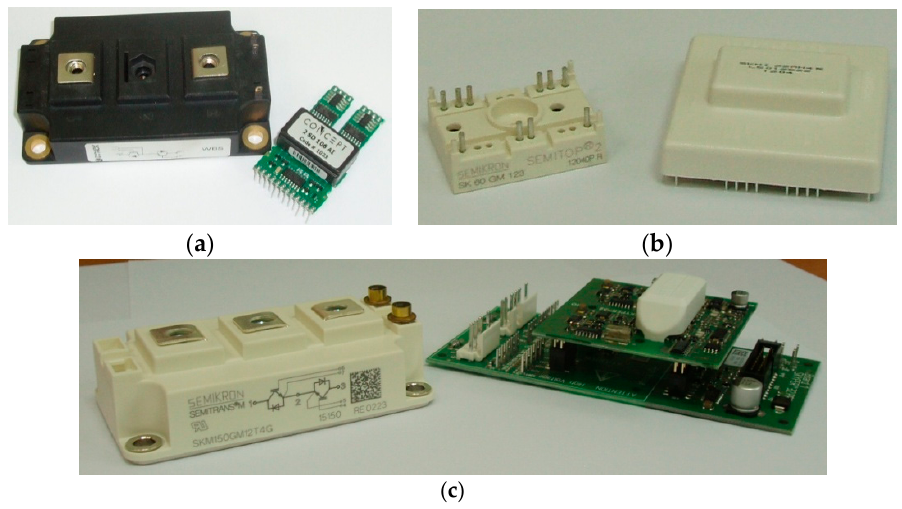
Figure 8. A photograph of the IGBTs with dedicated drivers: ( a ) Dynex IGBT with Concept driver; ( b , c ) Semicron drivers and IGBTs. Table 1. Available, selected commercial modules with bidirectional switches.